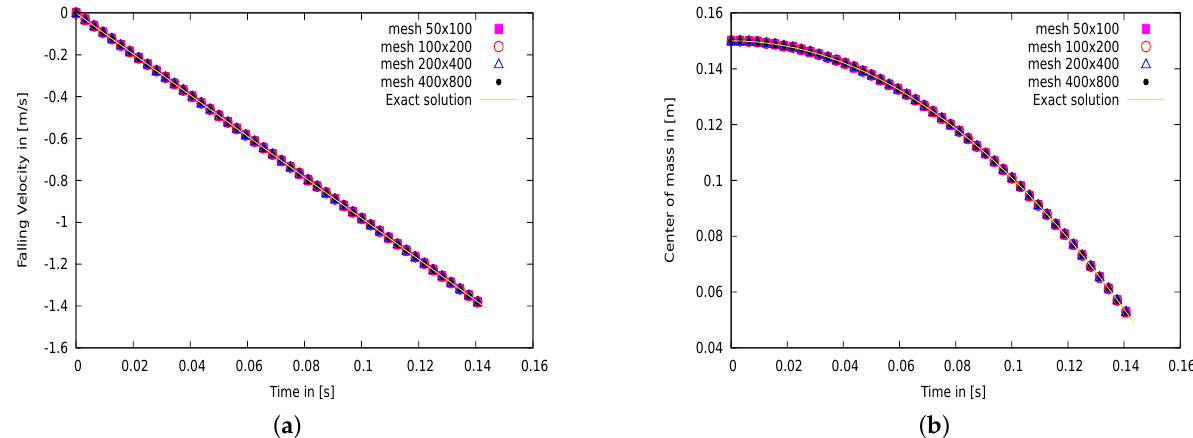
(cid:0) (cid:1) ρ 1 / ρ 2 = 10 5 , µ 1 / µ 2 = 10 10 obtained by the fully coupled